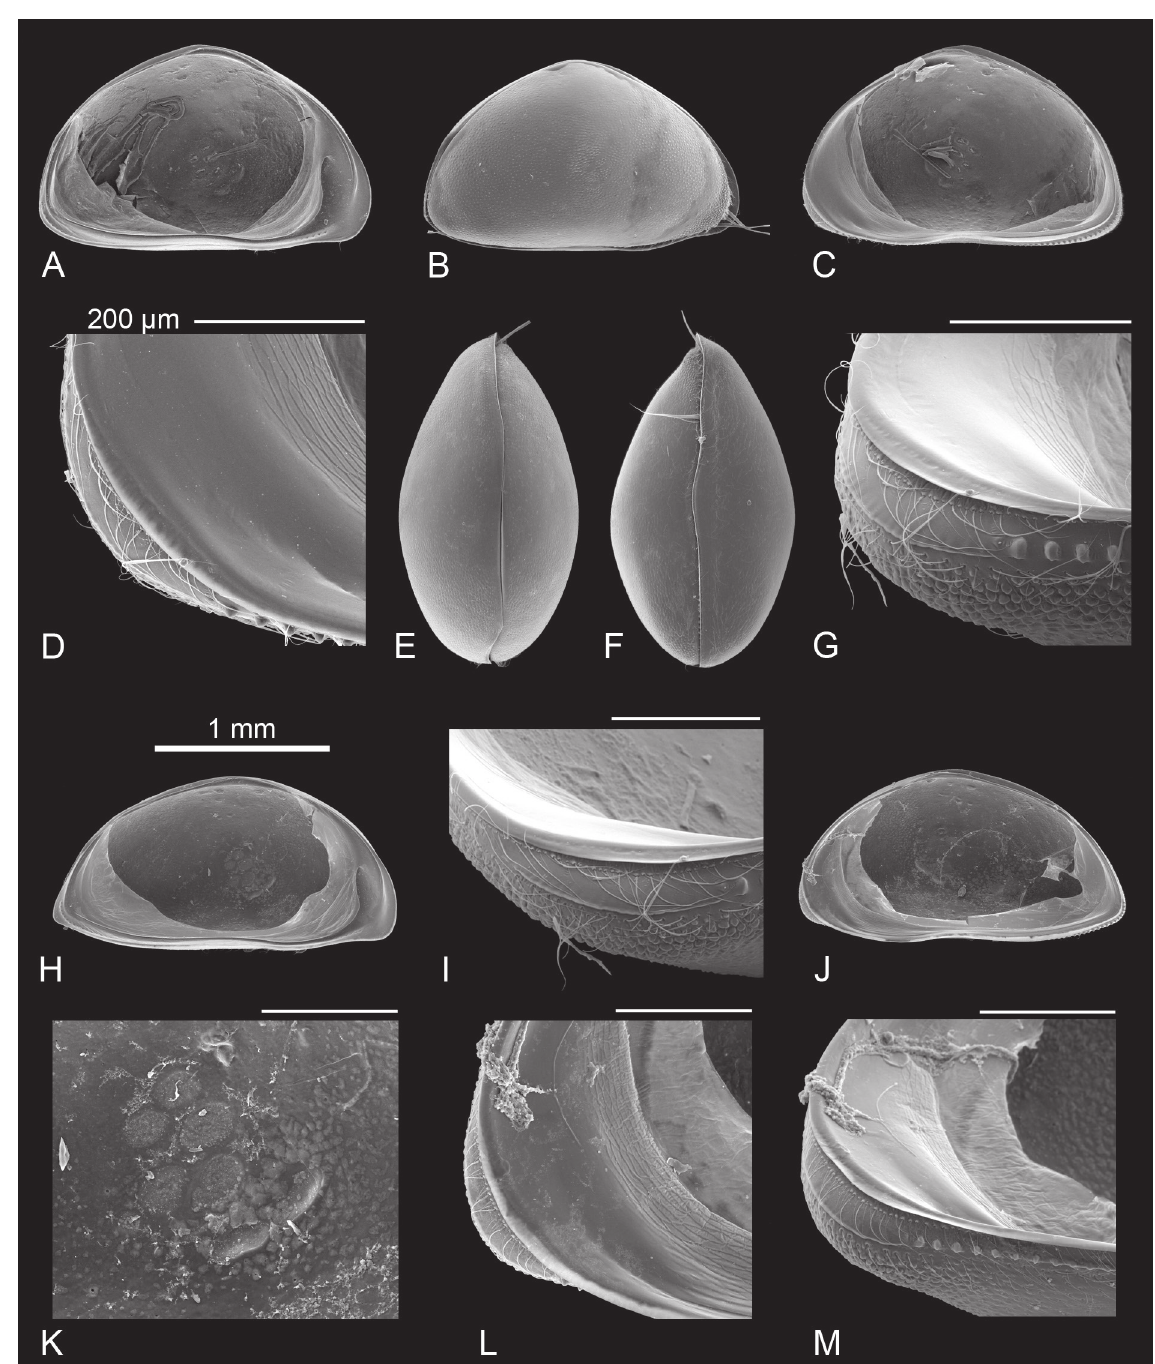
Fig. 12. Bennelongia triangulata sp. nov. (all ♂, A–G from type locality: canegrass pan on Wooramel Station, Murchison/Gascoyne, WA; H–M from CB54, Boolathana Station, Carnarvon Basin, WA). A . lVi (holotype, WAMC55564). B . CpRL (OC3369). C . RVi (WAMC55564). D . rVi, detail anterior margin (WAMC55564). E . CpD (WAMC55571). F . CpV (WAMC55572). G . rVi, tilted, detail anterior margin (WAMC55564). H . LVi (WAMC55574). I . RVi, tilted, detail anterior margin (WAMC55564). J . rVi (WAMC55574). K . LVi, detail central muscle scars (WAMC55574). L . rVi, detail anterior margin (WAMC55574). M . RVi, tilted, detail anterior margin (WAMC55574). Scale = 1 mm for A–C, E–F, H, J; 200 µm for D, G, I,